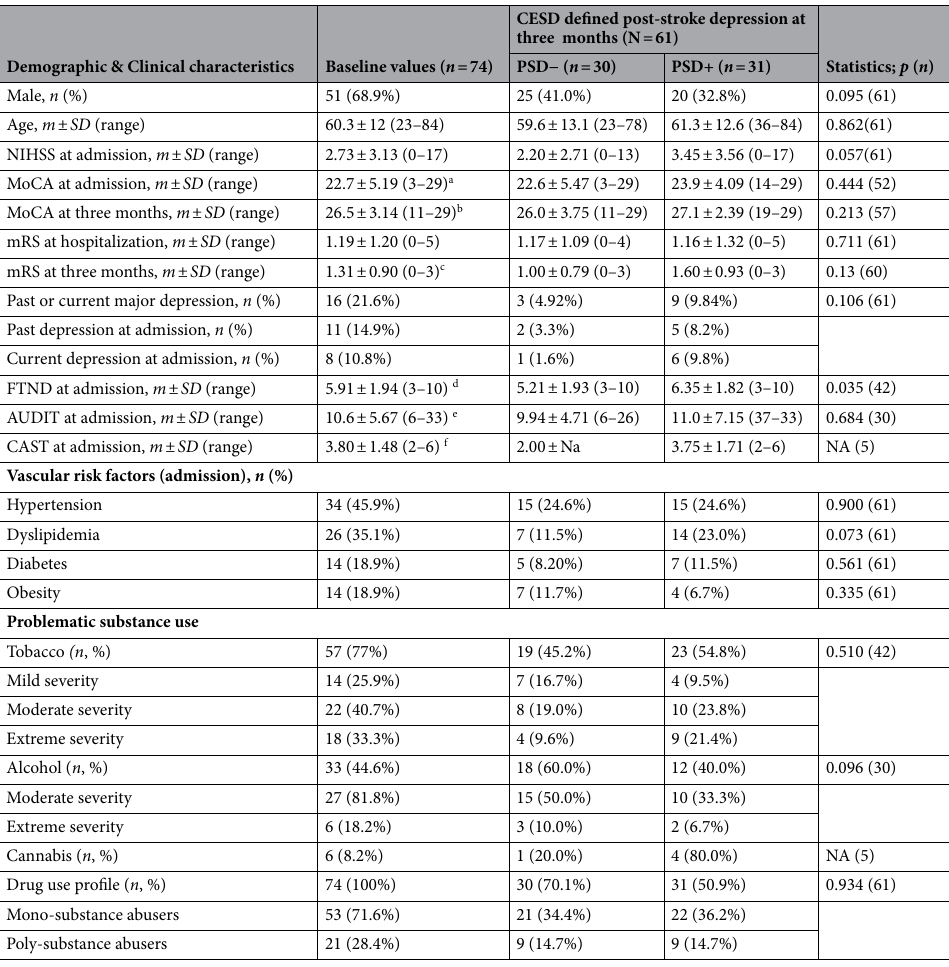
Table 1. Characteristics of the overall sample at baseline. AUDIT Alcohol Use Disorders Identification Test, CAST Cannabis Abuse Screening Test, FTND Fagerström Test for Nicotine Dependence, CESD Center of Epidemiological Studies Depression scale, MoCA Montreal Cognitive Impairment, mRS modified Rankin Scale, NIHSS National Institutes of Health Stroke Scale, PSD + Sub-group of patients with CESD scores indexing a moderate or severe depression, PSD − Sub-group of patients with CESD scores indexing no depression. a ( n = 62), b ( n = 58), c ( n = 61), d ( n = 54), e ( n = 33), f ( n =